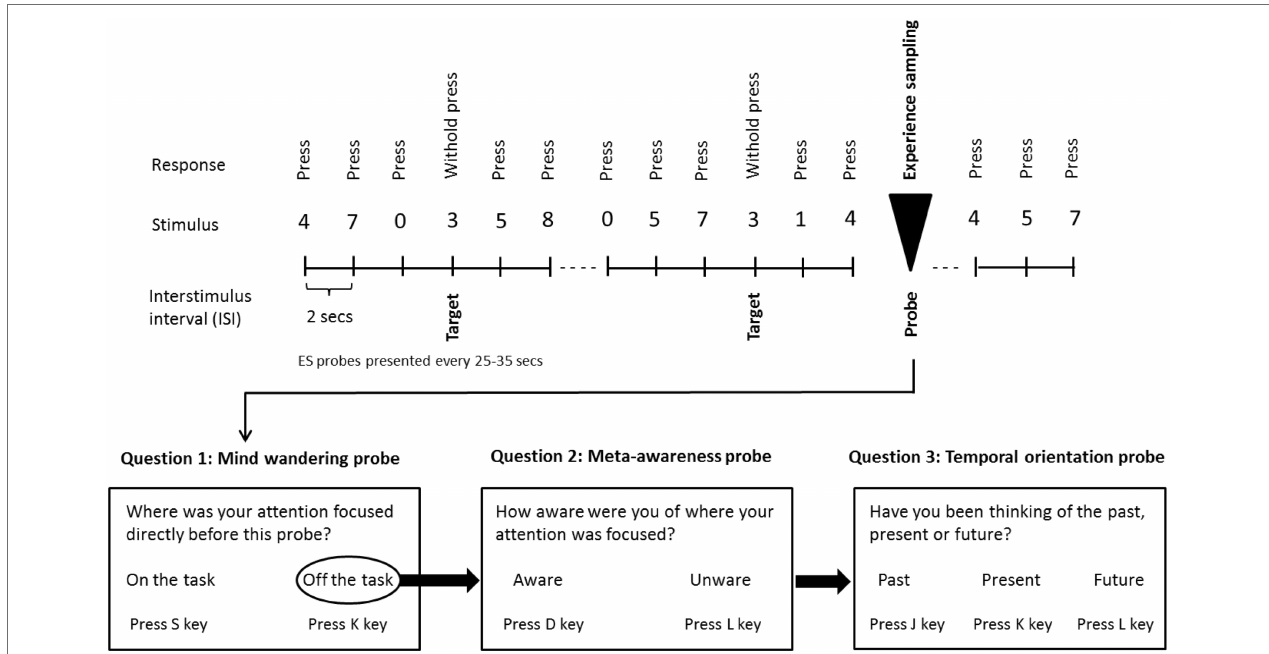
FIGURE 1 | Schematic illustration of the sustained attention to response task (SART) with embedded experience sampling probes. Subjects are instructed to respond with a button press when a non-target digit appears on the screen, with the exception of the target digit (3) for which they were instructed to withhold the button press. Subjects were also asked to respond to the embedded intermittent experience sampling probes when they appeared onscreen [probe 1: “Where was your attention focused immediately before the probe appeared?” (possible responses: “on task” or “off task”). Whenever participants indicated being “off-task,” a second probe assessed meta-awareness: “Were you aware that your attention was off-task?” (possible responses: “yes” or “no”). A third probe inquired as to the temporal orientation of MW: “Have you been thinking of the past, present or future?” (possible responses: “past,” “present,” and “future”)]. Participants were asked to respond as quickly and as accurately as possible.